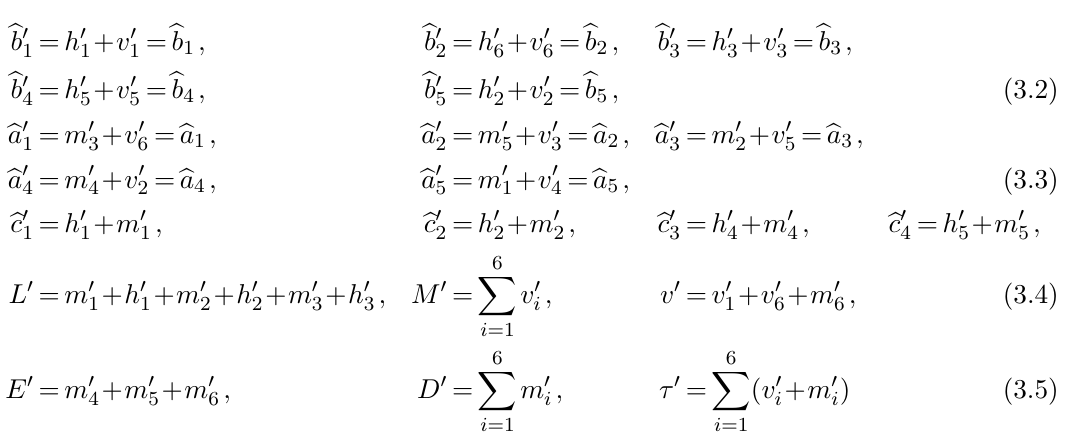
with shift (cid:14) = 1, and a labelling of the K(cid:127)ahler 3 ; 2